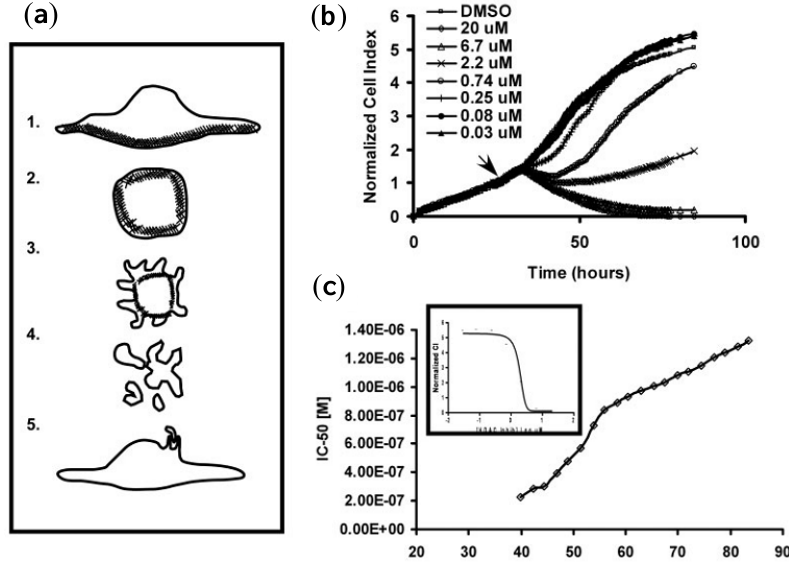
Figure 21. ( a ) Morphological changes associated with apoptosis. (1) shows a cell under normal physiological conditions. The apoptotic response leads to cell rounding (2) followed by membrane blebbing, which occurs due to weak interaction between the membrane and actin cytoskeleton (3), formation of apoptotic bodies (4), and ultimate actin-mediated engulfment of apoptotic bodies by neighboring cells (5); (b) Dynamic monitoring of cytotoxicity using the RT-CES system. A549 cells were seeded in microtiter plates containing interdigitated microelectrodes and treated with the HDAC inhibitor Scriptaid values for Scriptaid. The inset shows the at the indicated doses; ( c ) Real-time IC 50 dose-response to Scriptaid at a single time point. (Reprinted from [165]. © 2008, with permission from John Wiley and